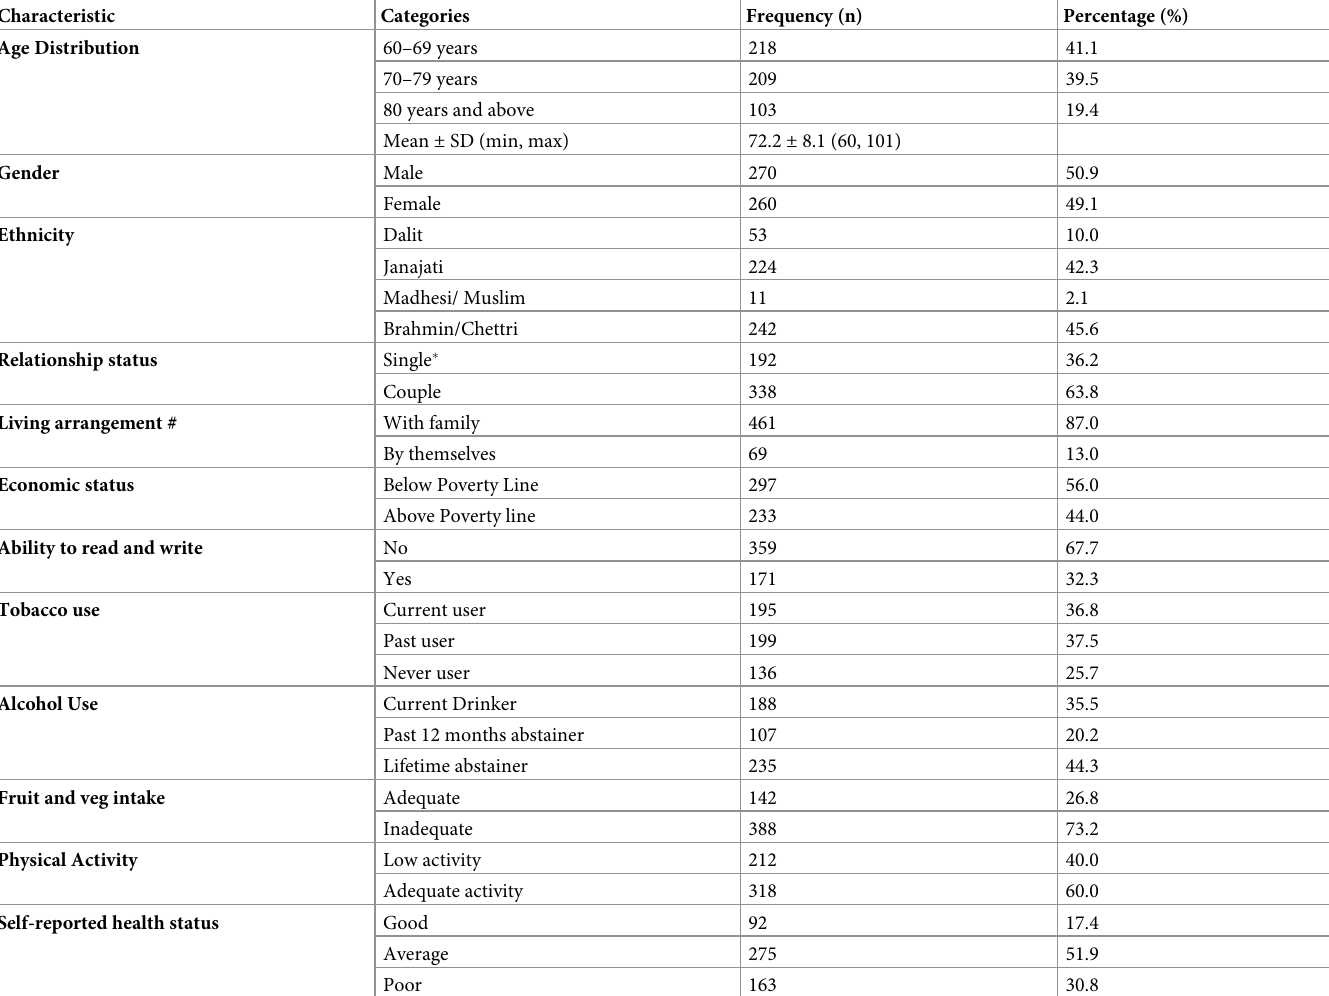
Table 1. Sociodemographic and behavioural characteristics of participants [n =